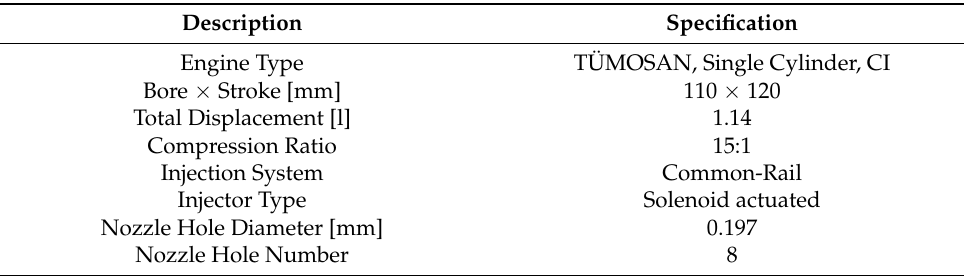
Figure 1. One-dimensional (1D) engine model. Table 2. Engine operating conditions for the post injection validation tests. Table 1. Engine and fuel system specifications.